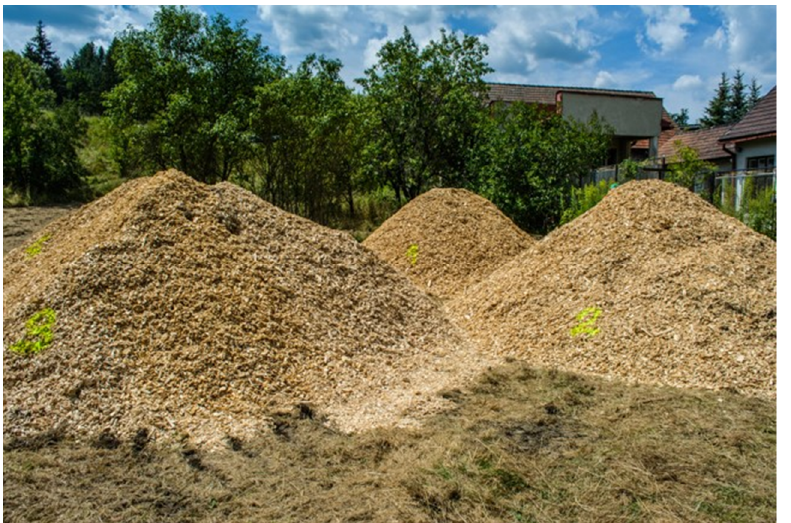
Figure 1. Percentage occurrence of recorded qualitative features and their average size in the entire sample of non-coniferous trees.